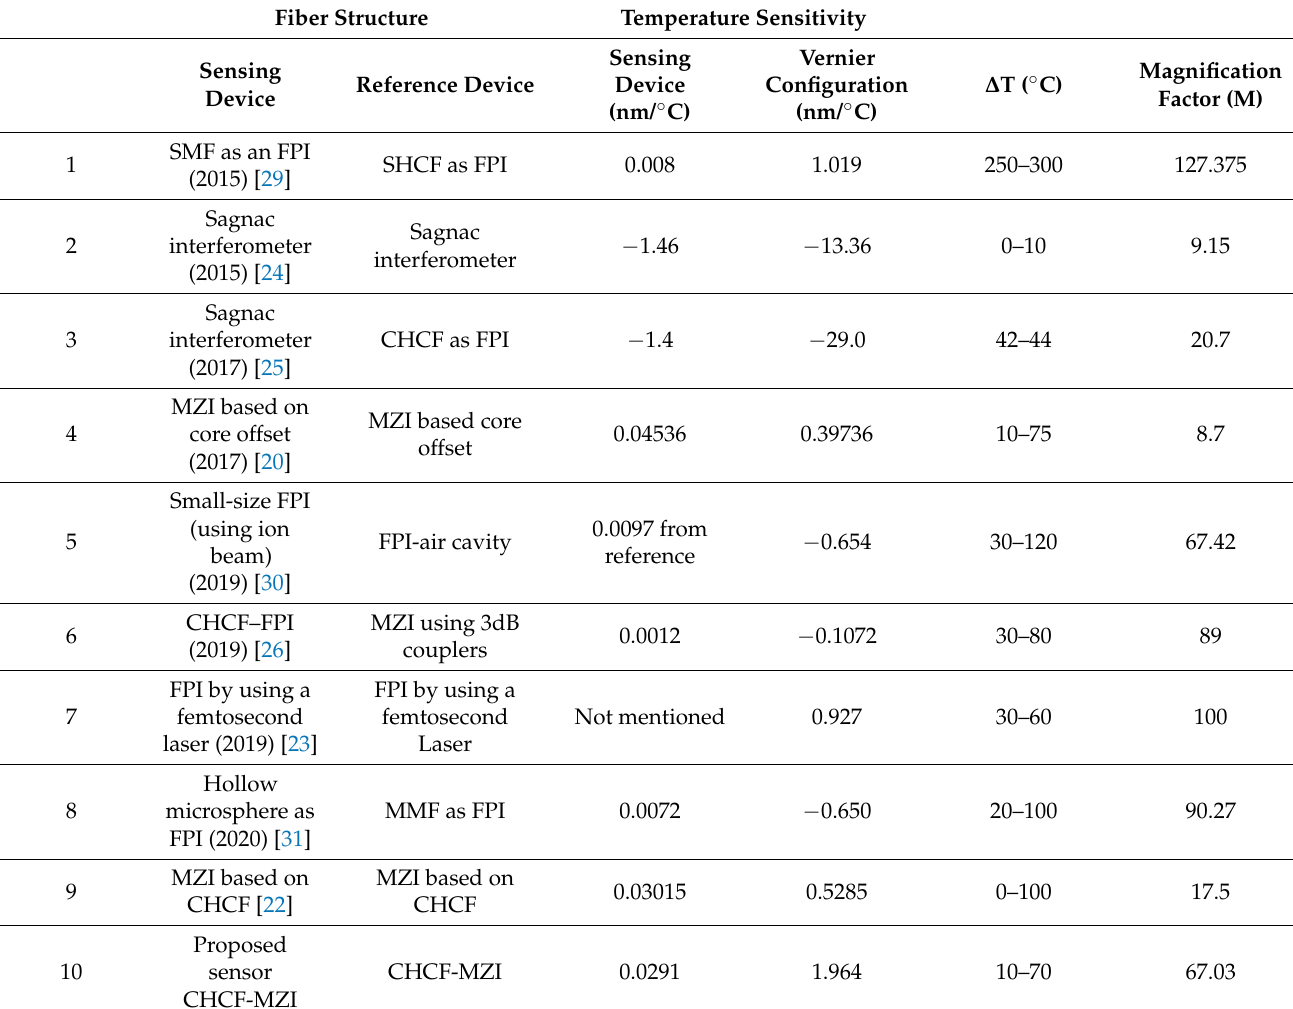
Table 5. Different all-fiber temperature sensors based on the Vernier